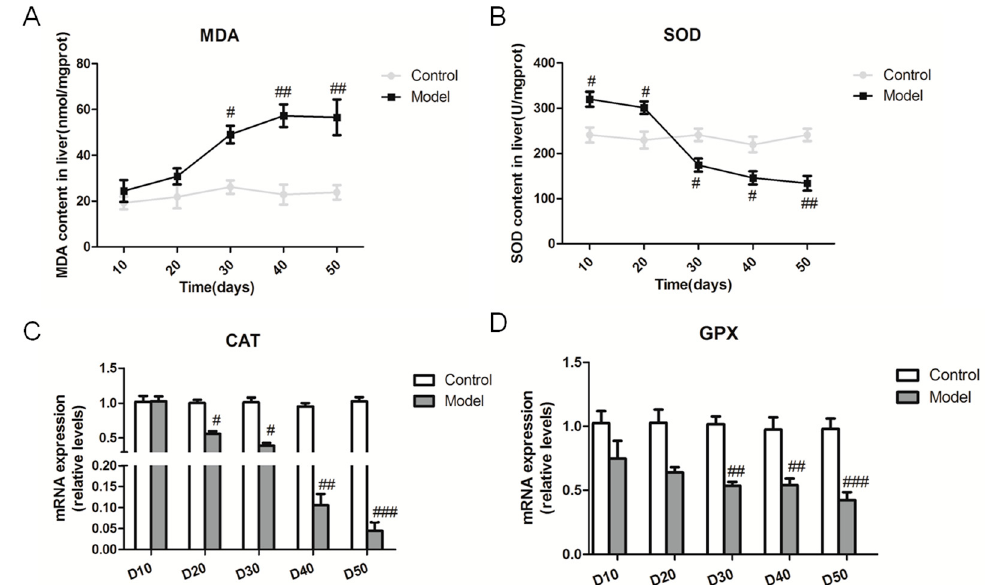
Figure 5. High fat-sucrose diet triggered hepatic oxidative stress in NASH rats. The hepatic oxidative stress of SD rats induced by the high fat-sucrose diet on day 10, 20, 30, 40, 50. ( A ) Malonaldehyde MDA) content; ( B ) Superoxide dismutase (SOD) content. The relative oxidative stress gene expression of CAT ( C ), GPX ( D ). The values are expressed as the means ± SEM ( n = 6). Compared with the corresponding control group, # p < 0.05, ## p < 0.01, ### p < 0.001.